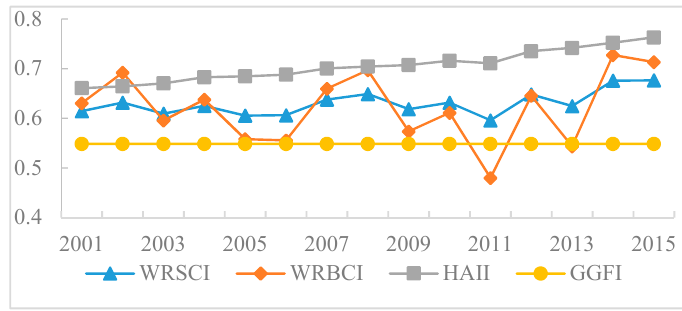
Figure 3. Changes in the Water Resources Security Index of Guizhou Province in 2001–2015.